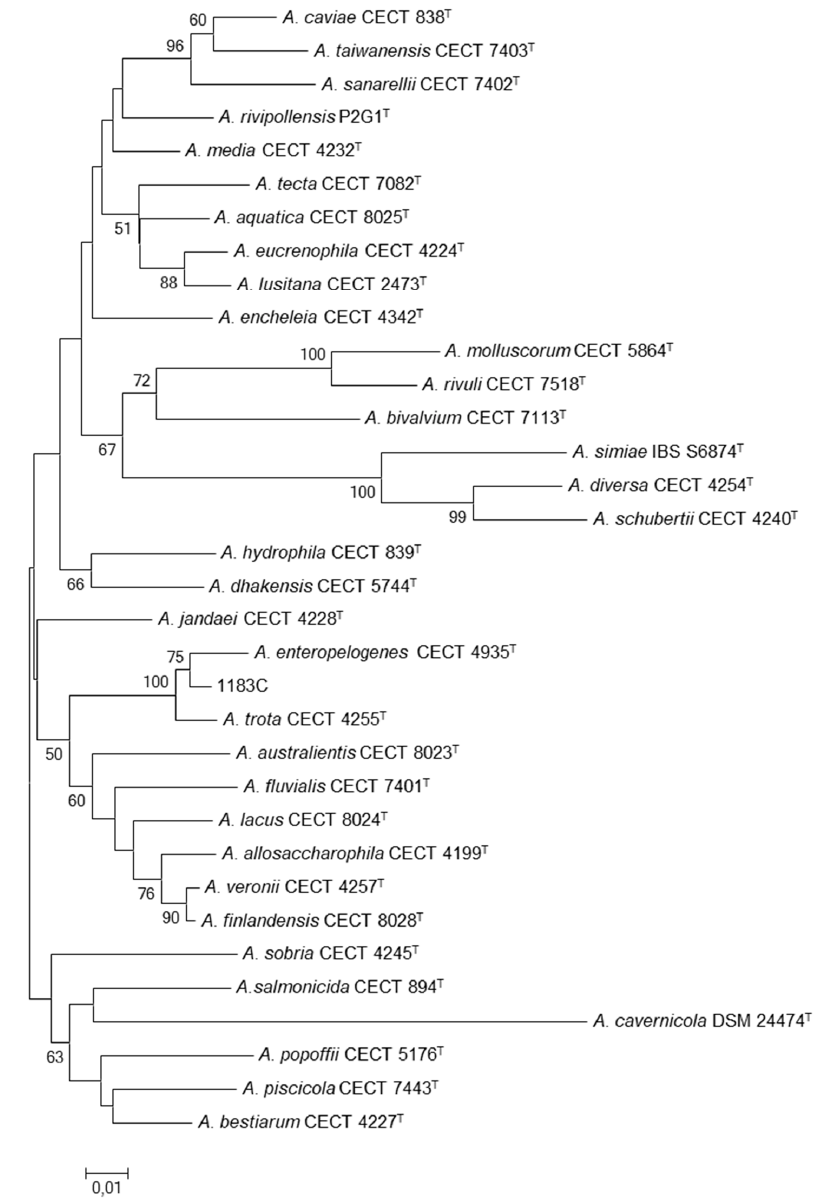
Figure 1. Phylogenetic tree based on rpoD gene (397 bp) with a neighbor-joining (NJ) algorithm. Numbers at nodes indicate bootstrap values (percentage of 1000 replicates). Bar 0.01 estimated nucleotide substitutions per site.